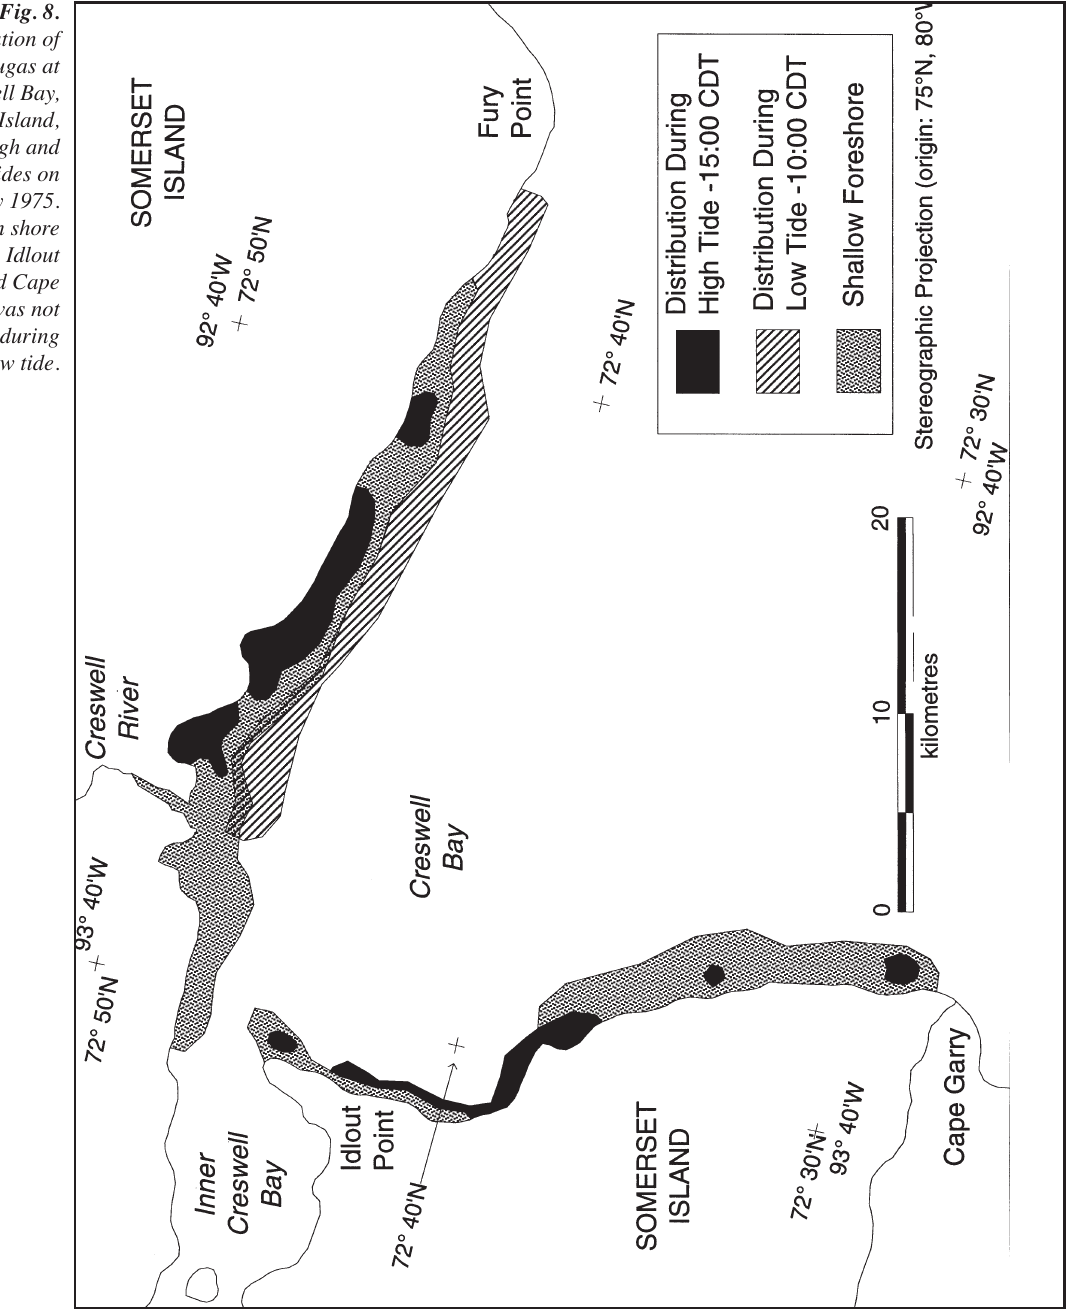
Fig. 8. Distribution